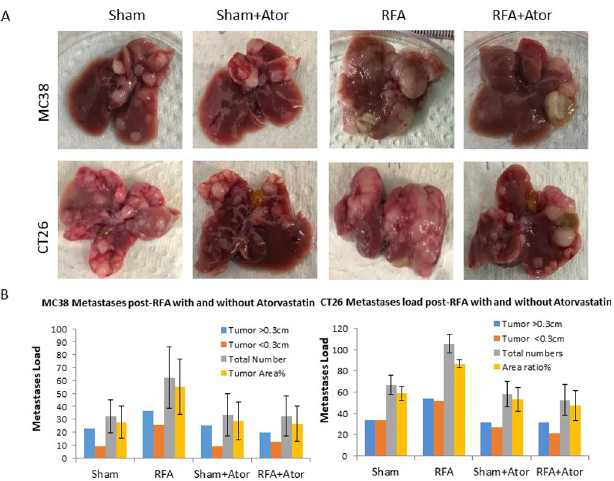
Fig 4. Myofibroblast blockade eliminates hepatic RF driven tumorigenesis of micrometastatic implants. RFA statistically significantly increased total number of tumor nodules, nodule size and tumor area ratio when compared to sham and sham plus multi-atorvastatin treatment and combination of RFA with atorvastatin in murine MC38 and CT26 colorectal metastatic models (p-value < 0.05, all comparisons). Additionally, RFA plus atorvastatin treatment demonstrated statistically significant lower tumor burden compared to RFA, with no statistically significant increase in tumor burden noted when compared to sham or sham plus atorvastatin treatment (p-value > 0.1 for all comparisons, both models).